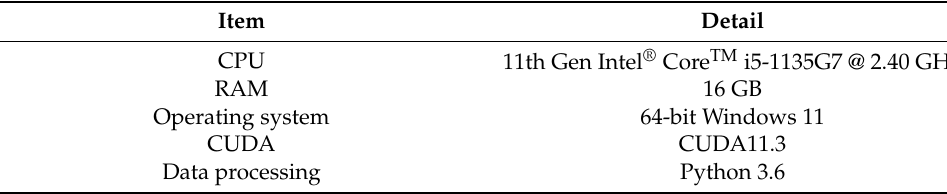
Table 2. Software and hardware configuration of experiments.